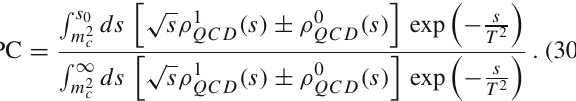
− ) − ) + ) + ) , ( sssc ¯ s , 3 , ( uuuc ¯ u , 3 , and ( sssc ¯ s , 3 , 2 2 2 2